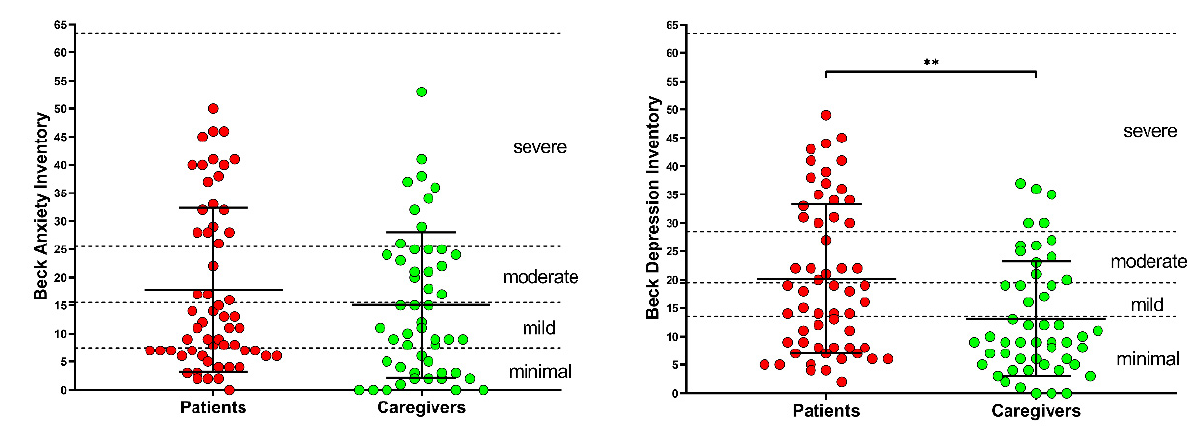
Figure 3. Beck Anxiety Inventory scores and Beck Depression Inventory scores in patients and caregivers. The asterisks indicate a statistically significant difference (** p < 0.01, according to the Mann–Whitney U test).